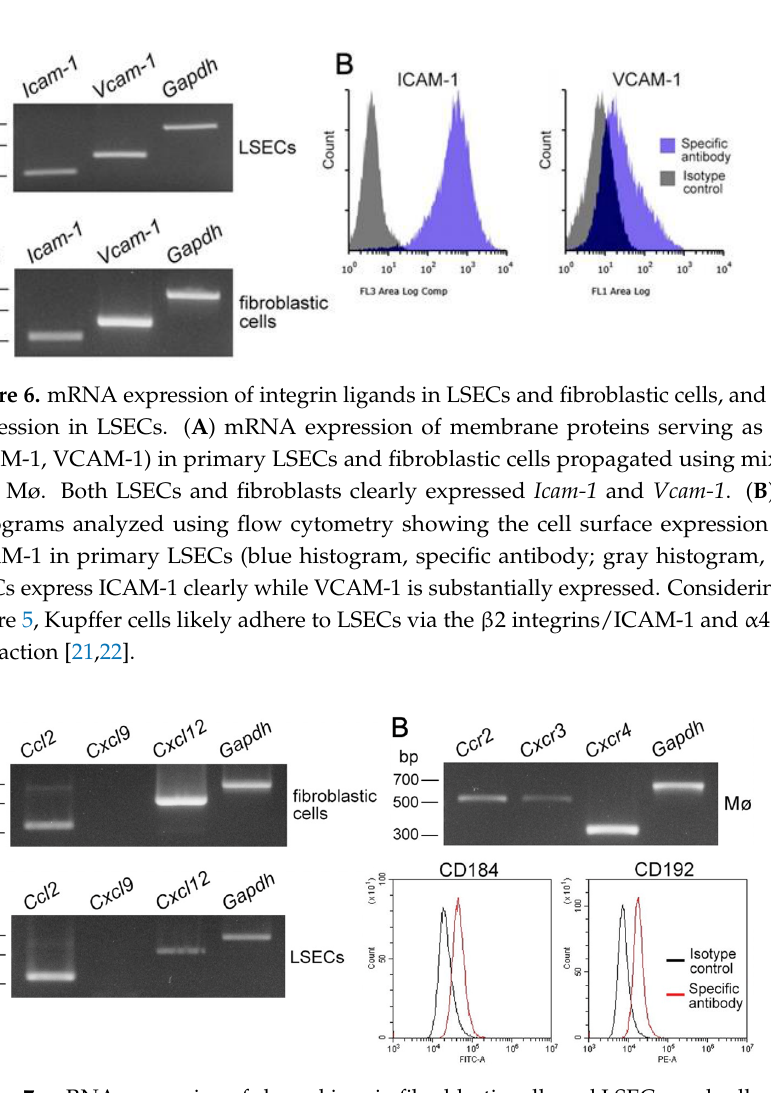
13 of 23 Figure 5. mRNA expression of integrin subunits and their cell surface expression in liver Mø prop- agated using mixed culture. ( A ) RT-PCR amplification of integrin s ubunits. Propagated liver Mø express Itga4 , Itga5 , Itga6 , Itgal , Itgam , Itgax , Itgb1 , and Itgb2 . ( B ) Representative histograms analyzed using flow cytometry show cell surface expression of α4, α5, α6, αL, αM, αX, β1, and β2 integrin subunits in the liver M ø (blue histogram, specific antibody; gray histogram, isotype control). Liver Mø express relatively large amounts of α5β1, α6β1, αLβ2, αMβ2, and αXβ2 integrins, and substan- tial amounts of α4β1 integrin. Chemokines rapidly induce integrin activation in leukocytes [23], and previous stud- ies have shown that LSECs and hepatic stellate cells express chemokines CCL2, CXCL9, and CXCL12, and Kupffer cells express chemokine receptors CCR2 and CXCR3 [24]; CXCL12/CXCR4 regulates the function or differentiation of monocytes/Mø [25]. Thus, we examined chemokine expression in propagated LSECs and fibroblastic cells, as well as the